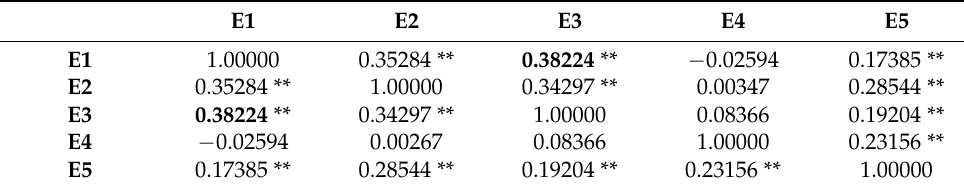
Table 5. Spearman correlation